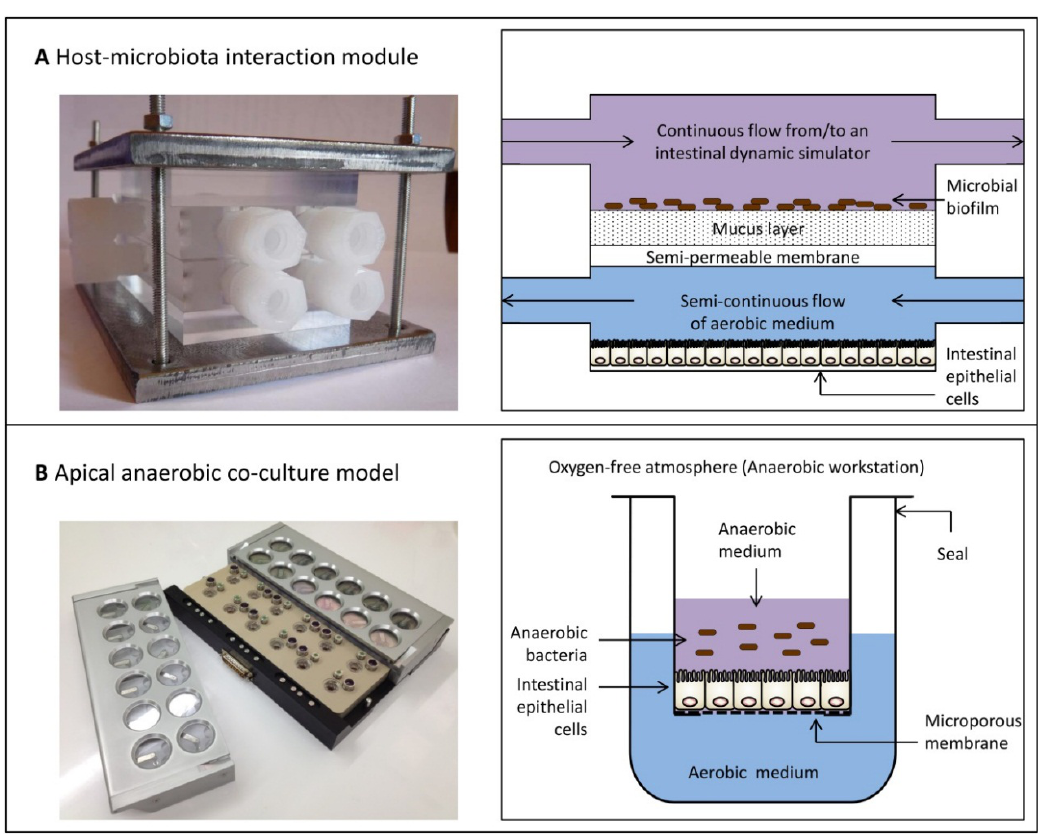
Figure 2. Comparison of two examples of dual-environment co-culture models. ( A ) The Host-Microbiota Interaction (HMI) module enables the co-culture of a complex microbial community, including obligate anaerobic bacteria, with enterocyte-like cells [129,130]. This in vitro model consists of two compartments, the upper compartment representing the luminal side containing a complex microbial community and the lower compartment containing enterocyte-like cell lines. These two compartments are separated by a polyamide semipermeable membrane and a mucus layer. The HMI module can be used to investigate host-microbiota interactions for up to 48 h. ( B ) The apical anaerobic co-culture model also contains two compartments. The upper compartment contains anaerobic medium to enable the survival of obligate anaerobic bacteria and the lower compartment is filled with aerobic medium to enable the survival of oxygen-requiring human IECs. In this model the two compartments are separated by a microporous membrane, on which IECs are seeded. By diffusion through the microporous membrane, IECs receive oxygen from the lower aerobic compartment. The apical anaerobic co-culture model has been validated to study host-microbial interactions for up to 12 h [99]. Photograph of the HMI module is used with permission from Marzorati et al. [130], Agro Food Industry Hi-Tech, Tekno Scienze © 2012. Schematic of the HMI module is adapted from Marzorati et al. [129], BMC Microbiology, published by BioMed Central,